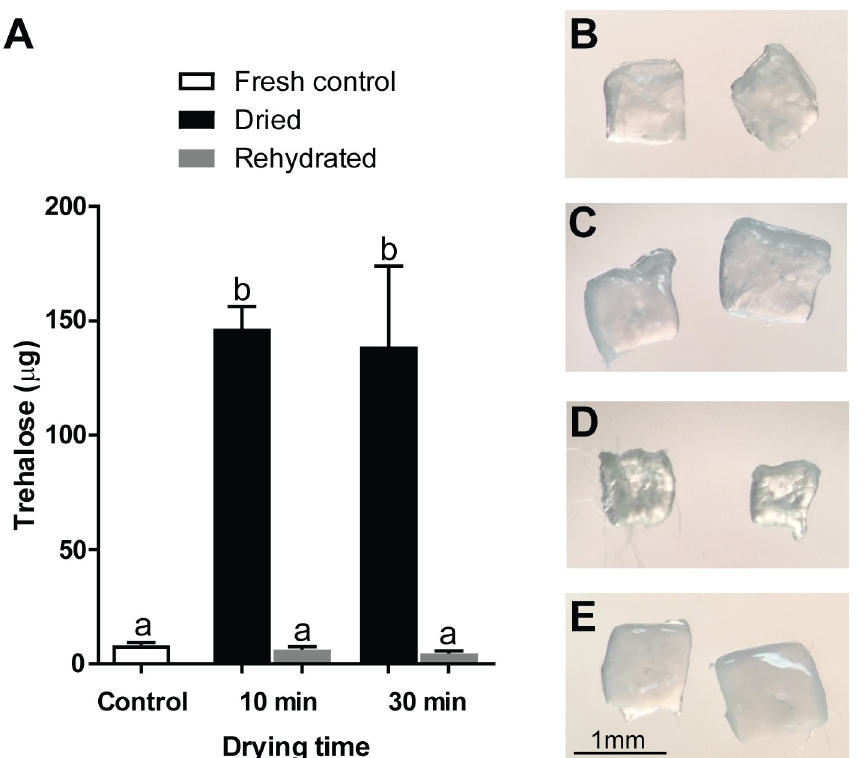
Fig 4. Effect of drying and rehydration on trehalose content and gross morphology of ovarian tissue. (A) Trehalose levels after dehydration and rehydration. Values are mean ± SEM. Values with different letters differ ( P < 0.05). (B-E) Gross morphology of whole ovarian cortical pieces that were (B) un-treated, (C) exposed to 0.5 M trehalose for 10 min, (D) dried for 30 min, and (E) rehydrated for 30 min.